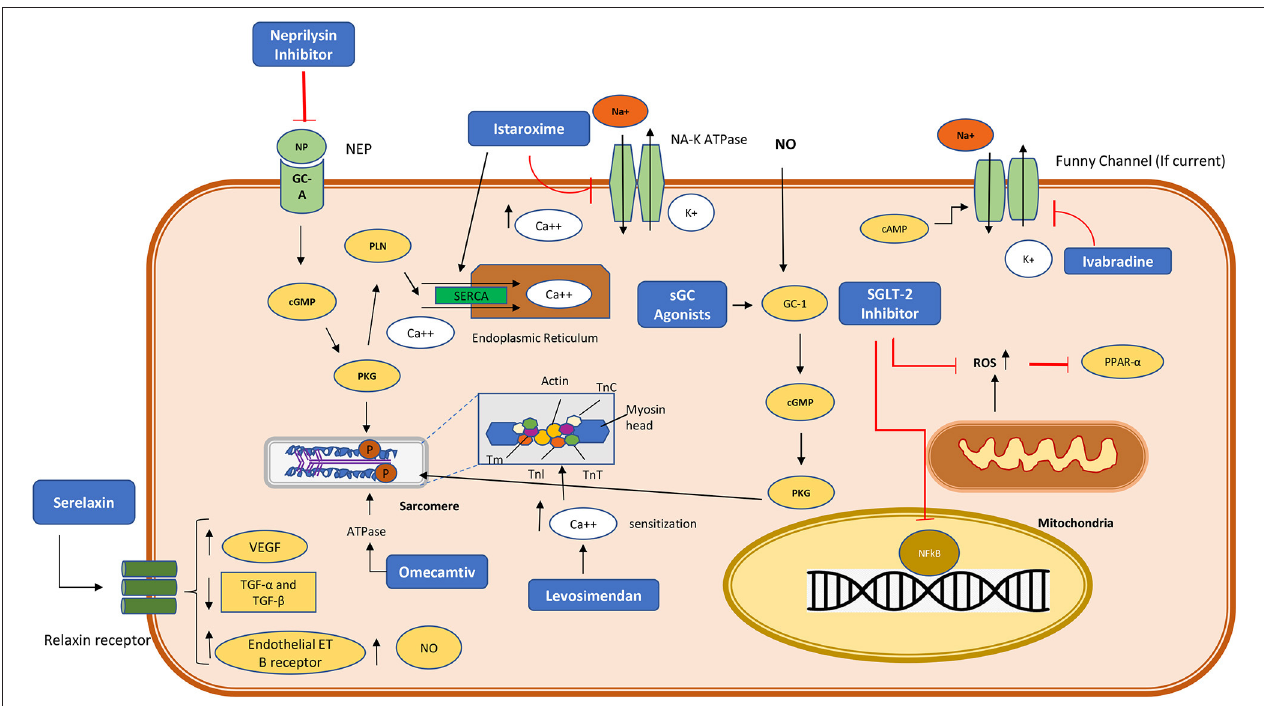
FIGURE 2 | Cardiomyocyte pathway of action of the newer drugs currently used or proposed in heart failure. NP, neprilysin; sGC, soluble guanylate cyclase; cGMP, cyclic guanylate monophosphate; SGLT-2, Sodium glucose co-transporter- 2; P, phosphorylation modification; ROS, reactive oxygen species; PPAR- α , peroxisome proliferator activated receptor alpha; NO, nitric oxide; NF κ B, Nuclear factor kappa B transcription factor; cGMP, cyclic guanylate monophosphate; PLN, phospholamban; SERCA, sarcoplasmic/endoplasmic reticulum Ca2 + -ATPase; ATP, Adenosine triphosphate; cAMP, cyclic adenosine monophosphate; VEGF, Vascular endothelial growth factor; ET, endothelin receptors; TGF, Transforming growth factor. PKG, protein kinase G; TnI, troponin I; TnC, troponin C; TnT, troponin T; Tm,